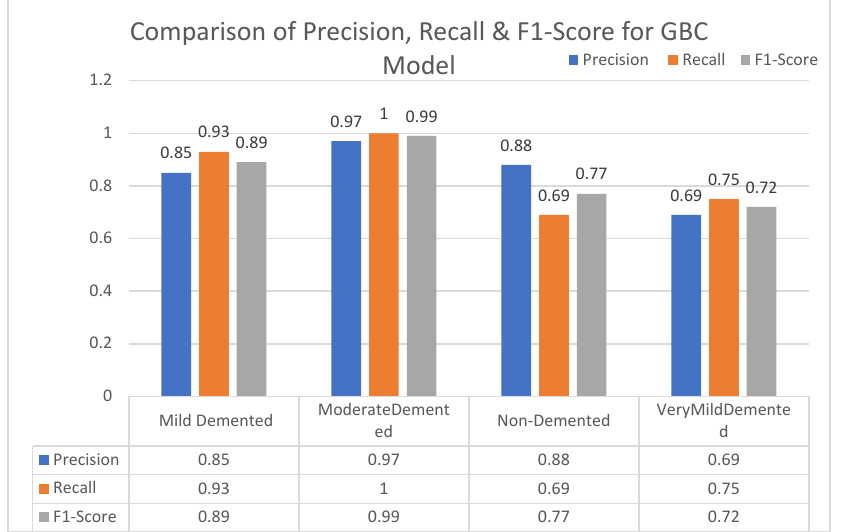
Figure 15. Visualization of Diagnostic Test for GBC Model.